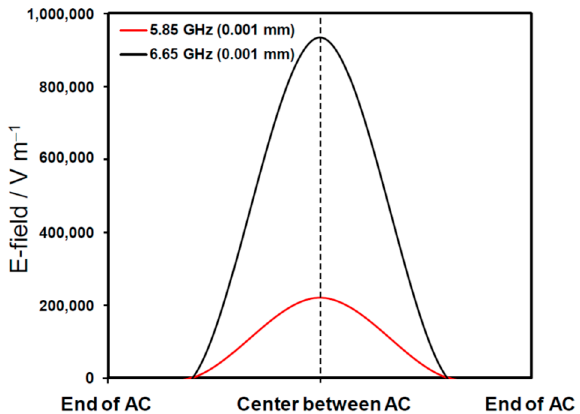
Figure 5. Distribution of the microwaves’ E -fields (V m − 1 ) around two activated carbon particles in toluene solvent for FFM at 5.85 and at 6.65 GHz simulated with the COMSOL Multiphysics software version 4.3a. The gap between AC particles (end to end of ACs) was set at 0.001 mm.